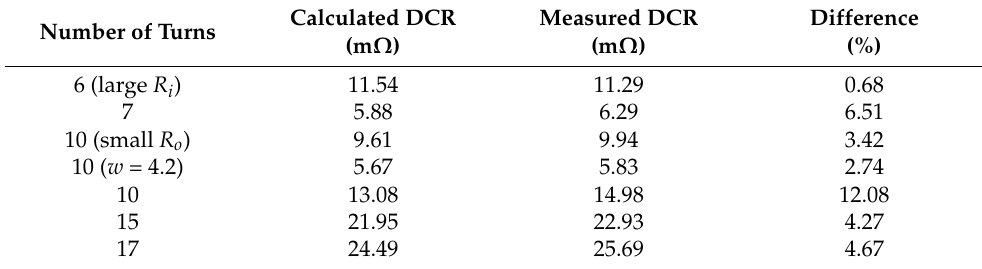
Table 6. Comparison between the calculated and the measured DC resistance of coil.